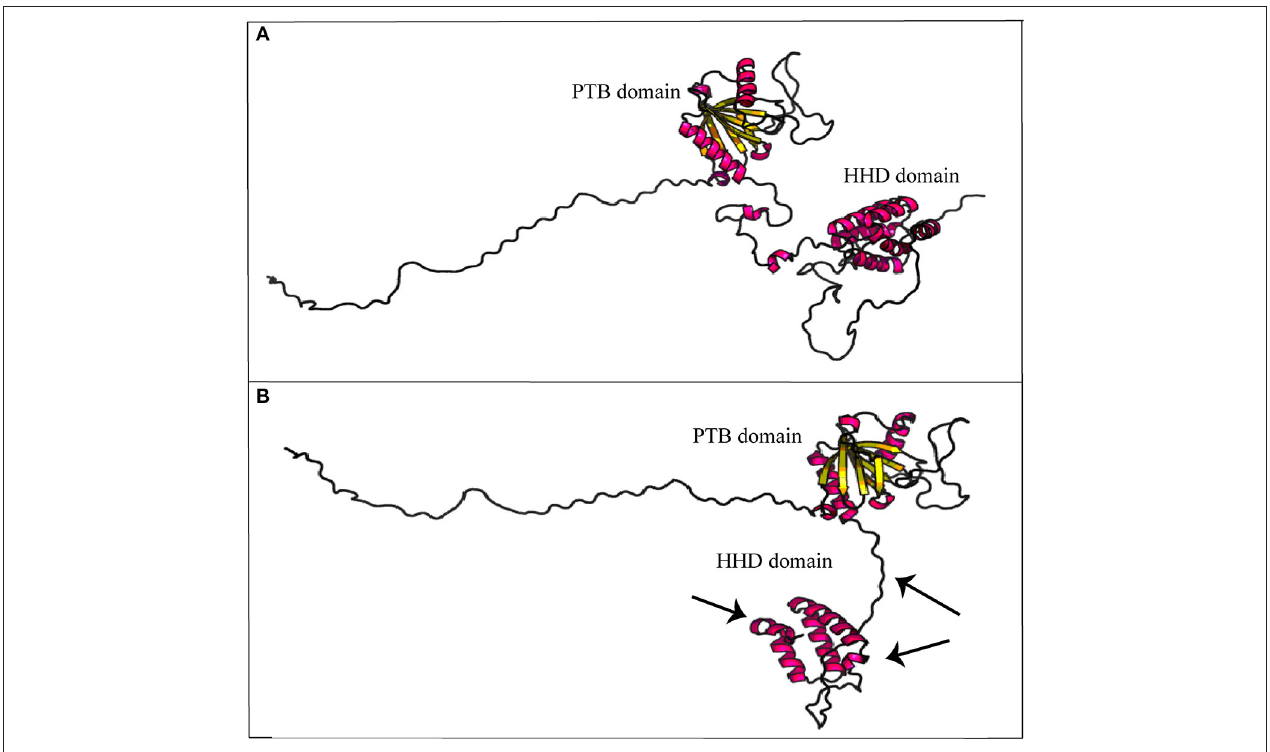
FIGURE 5 | Secondary structure prediction of mutated malcavernin. The image compares native (A) and mutated (B) malcavernin secondary structures. As indicated by the arrows, the main structural modifications affect harmonin-homology domain (HHD) at C-terminus with consequent loss of two helices. Images were obtained by “Structure Prediction” module of RaptorX